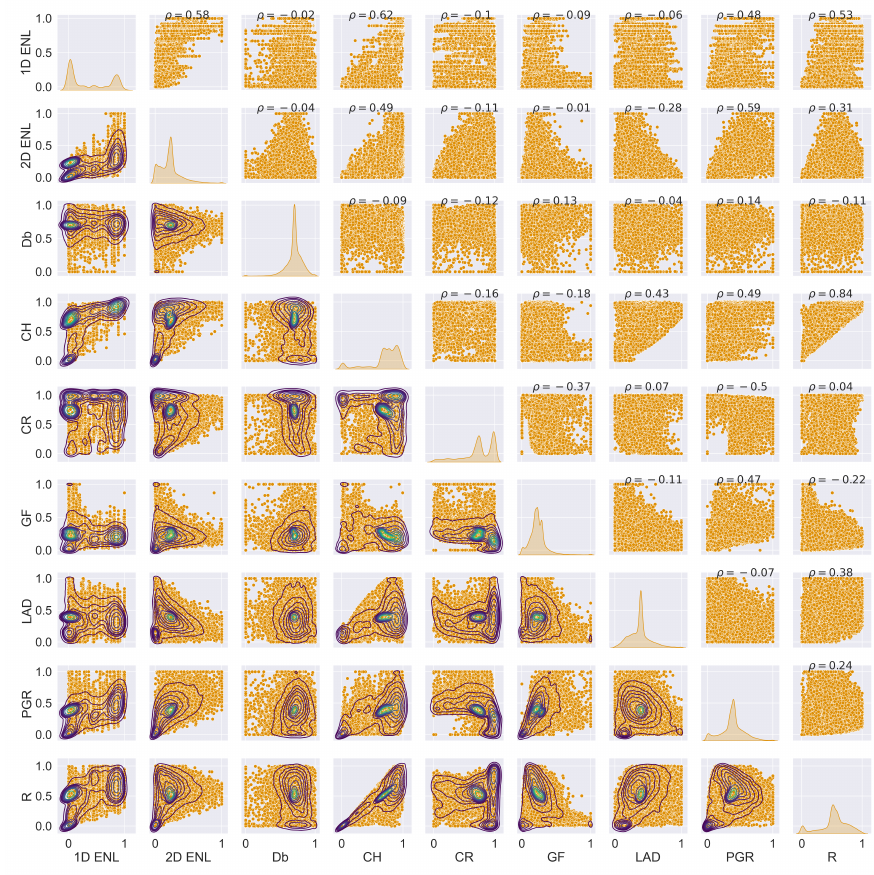
Figure A2. Scatterplot matrix of TLS traits at 0.5 m grid size.